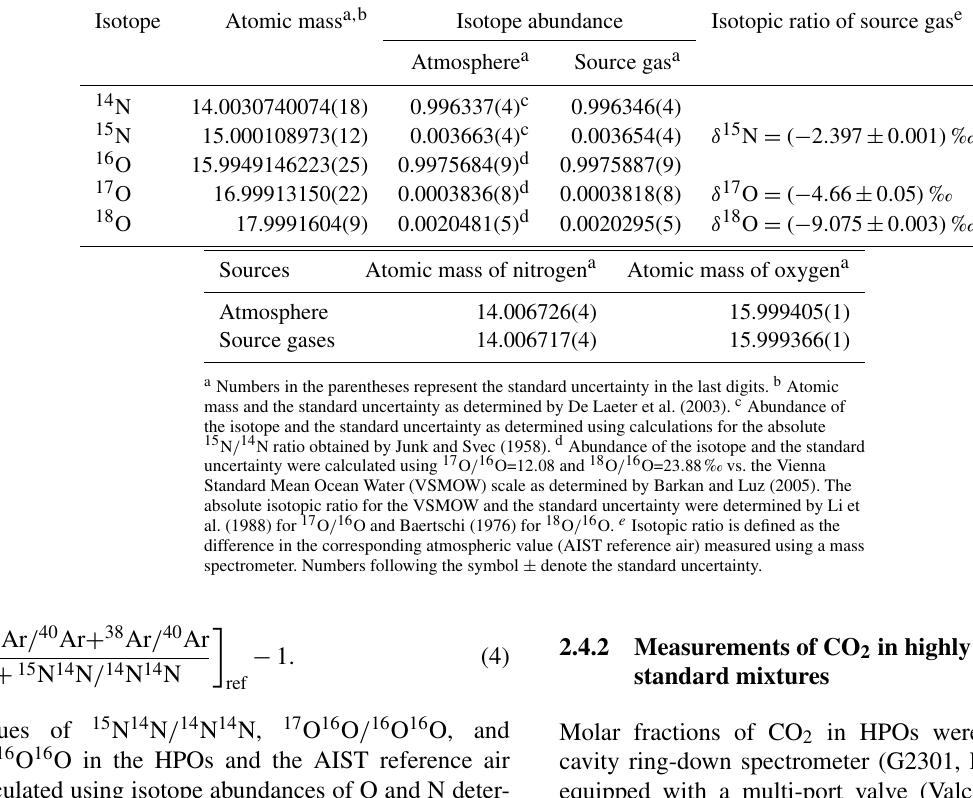
Table 1. Isotopic composition and atomic masses of pure oxygen and pure nitrogen used to prepare highly precise O 2 standard mixtures